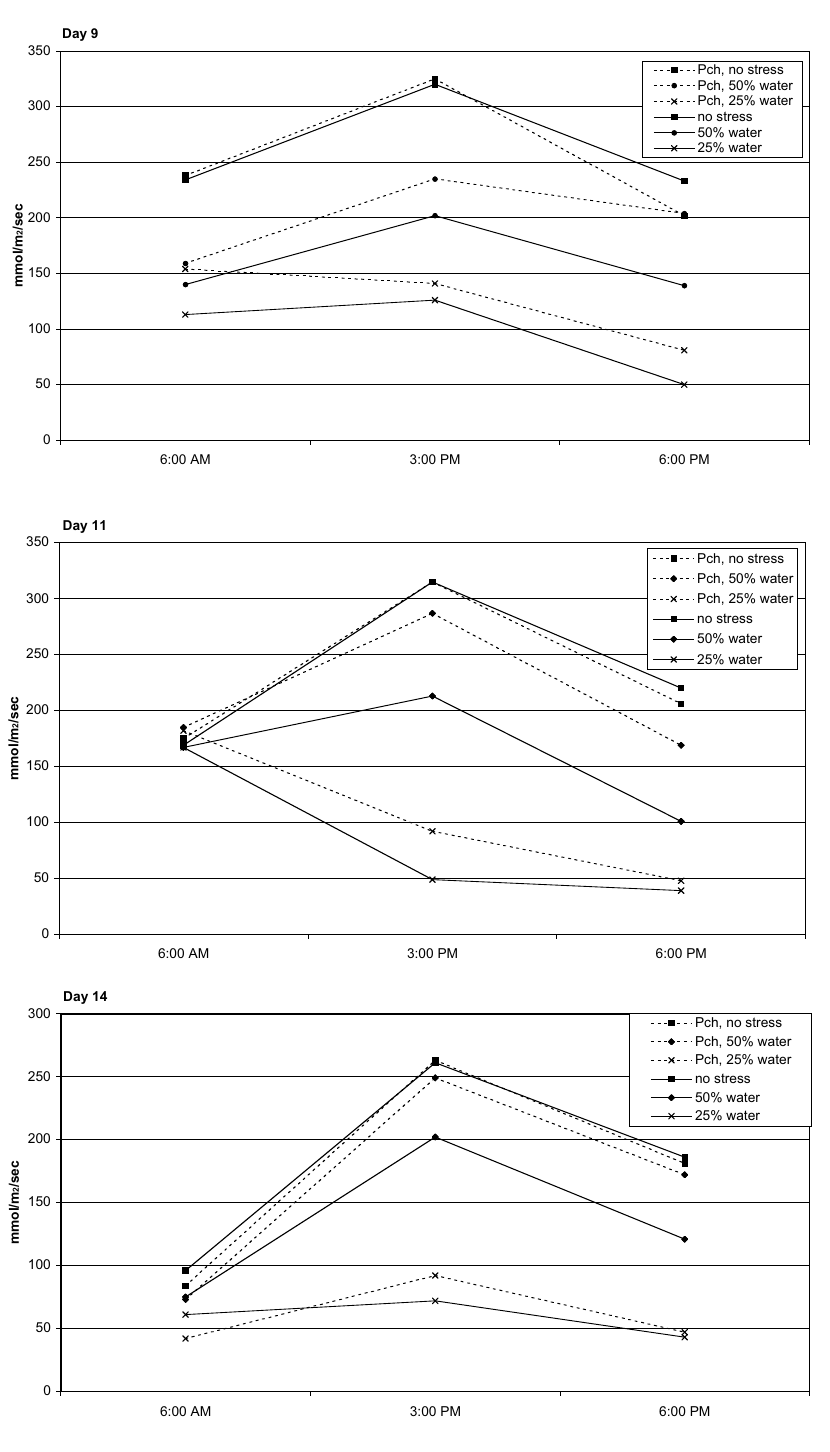
Fig. 3. Effect of 9, 11 and 14 days water stress on stomatal conductance of infected and uninfected Cabernet Sauvi- gnon, November